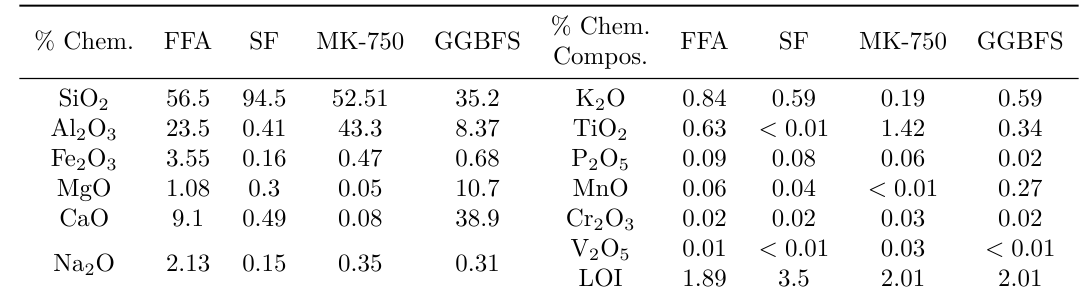
Table 2. Chemical Composition of